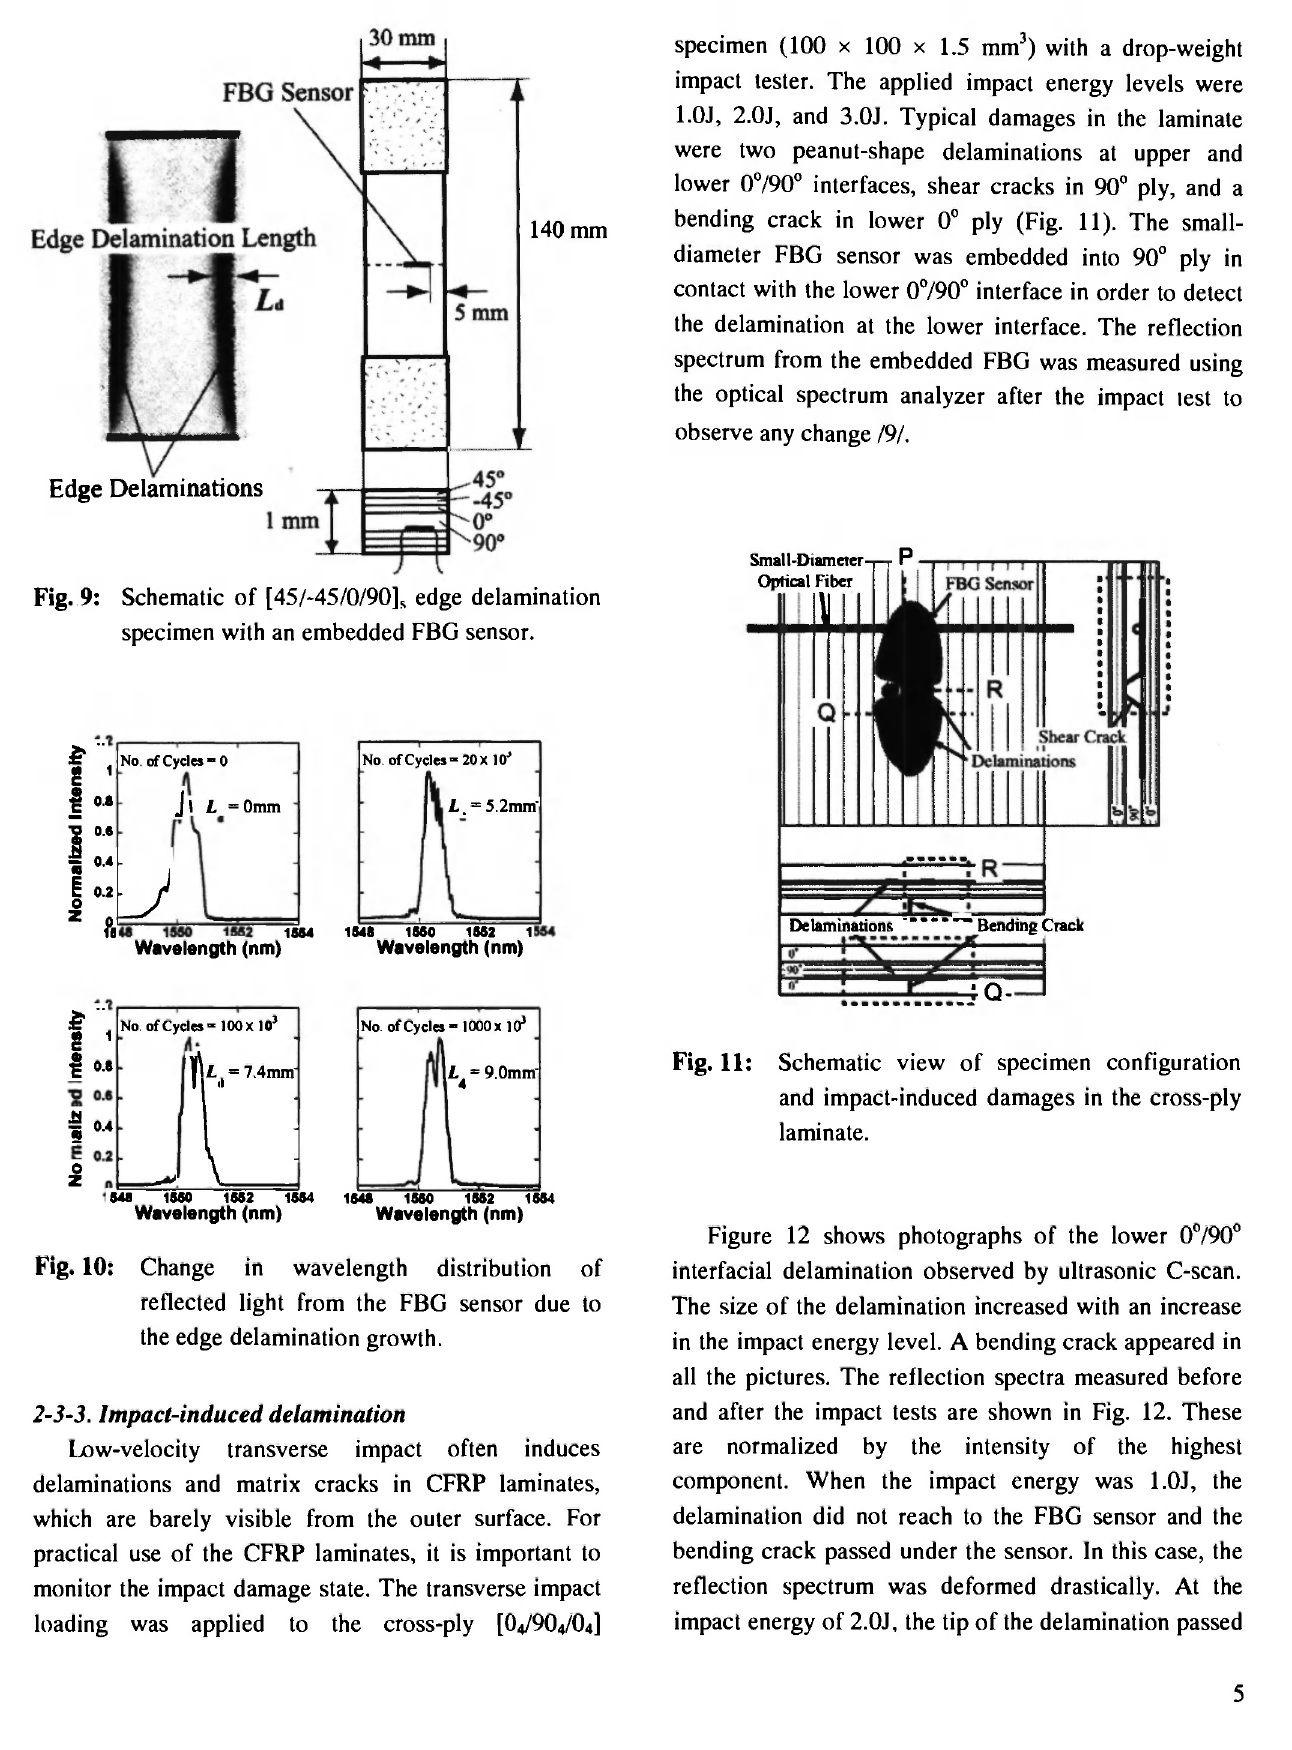
Fig. 9: Schematic of [45/-45/0/90] s edge delamination specimen with an embedded FBG sensor.